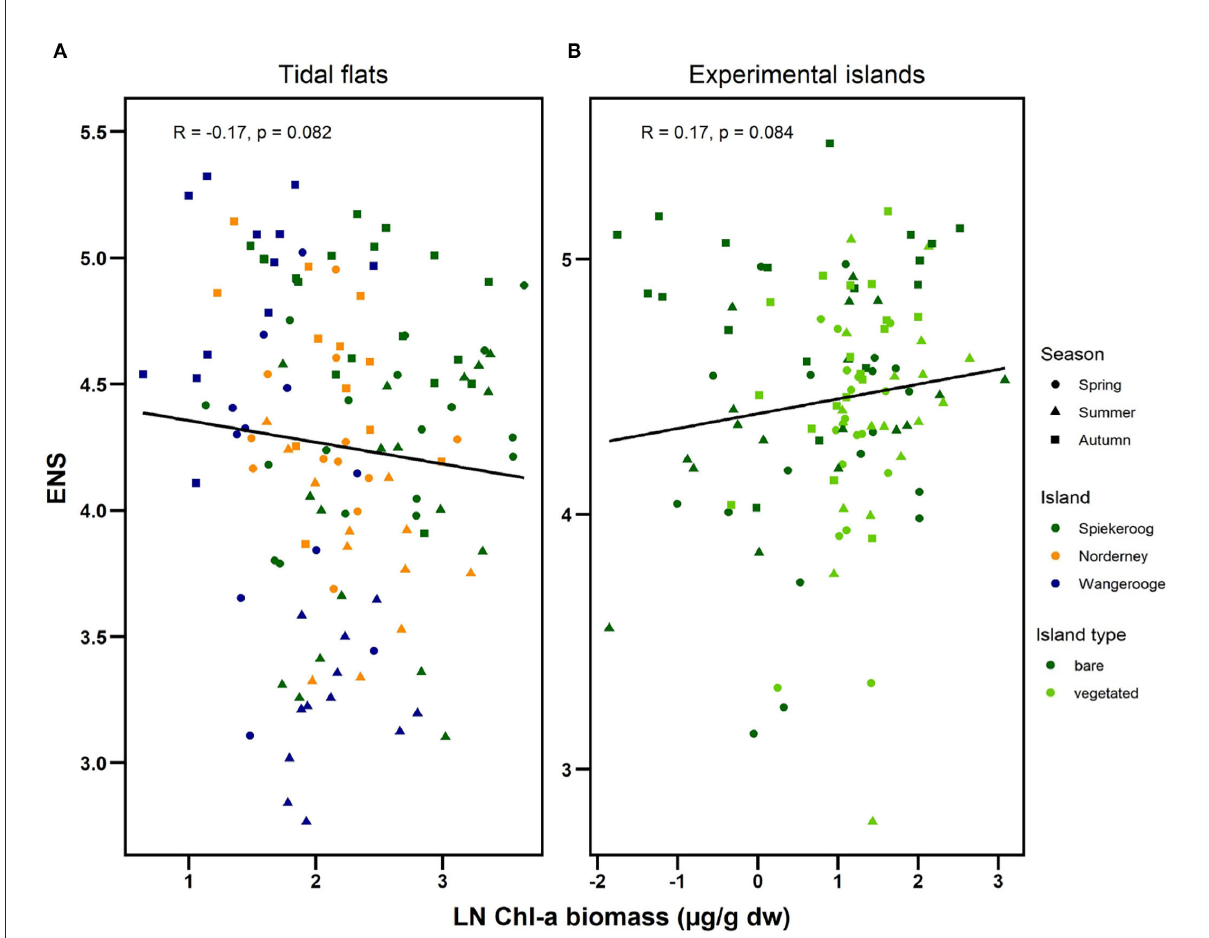
FIGURE2 Correlation test results between logarithmic-transformed Chl-a biomass in micrograms per gram dry weight sediment ( µ g/g dw) and pigment diversity [effective number of species (ENS)] on natural tidal flat transects (A) and on experimental islands (B) . Shapes represent seasons and colored symbols represent island location or island type (bare or vegetated experimental